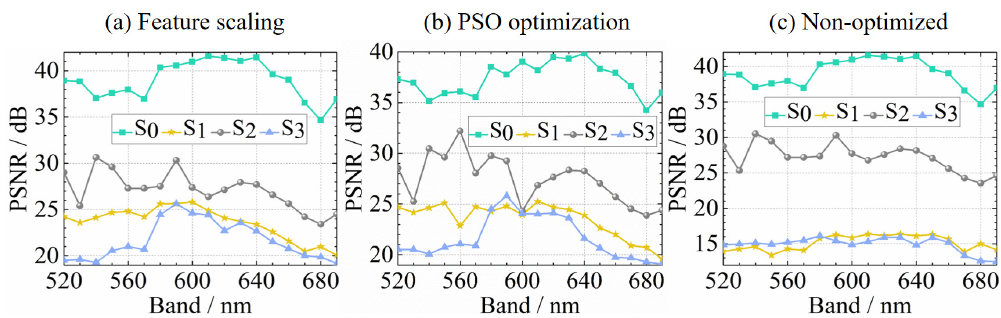
Figure 6. The PSNR values of polarized hyperspectral images reconstructed with ( a ) feature scaling, ( b ) the sparse basis optimized by PSO, and ( c ) non-optimized